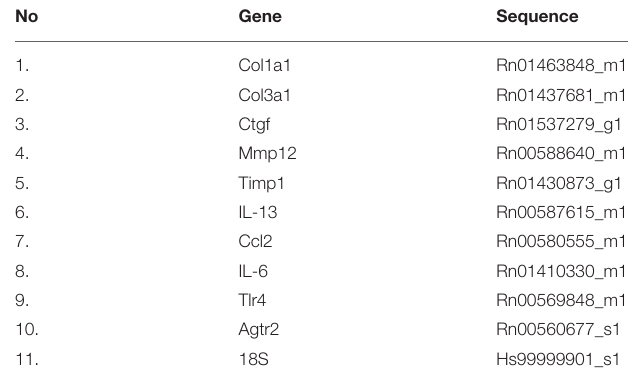
TABLE 1 | Rat primers used for RT-PCR experiment.